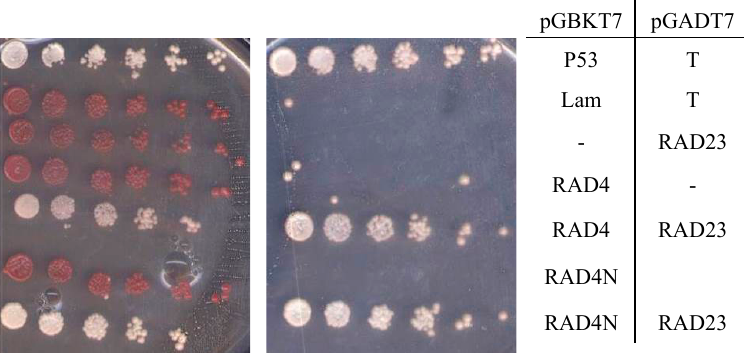
despite a potential redundancy within the RAD23 family, rad23 single mutants were sensitive to UV damage.